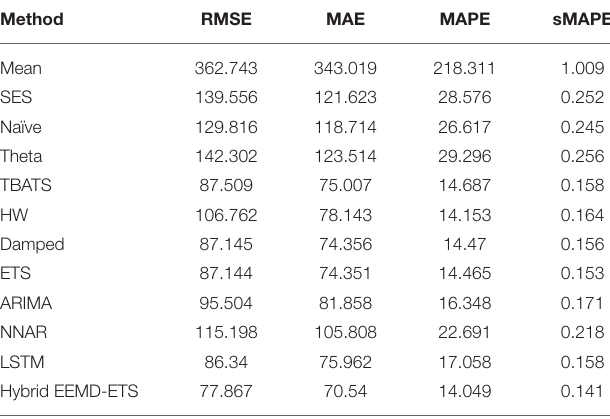
TABLE 6 | Performance comparison of different models for 7 days prediction of Italy’s daily deaths.